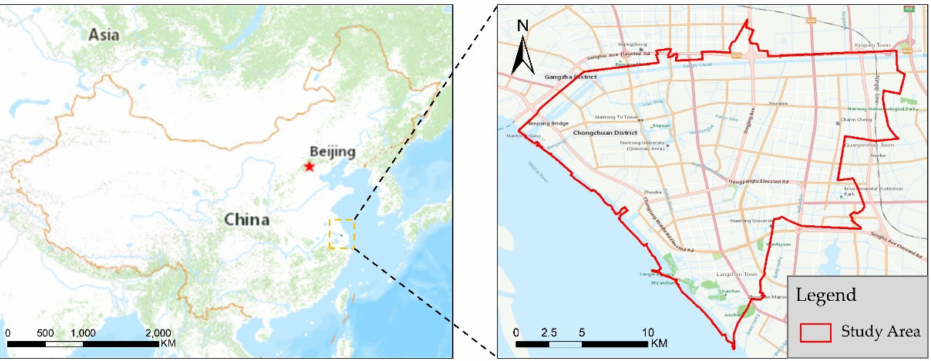
Figure 2. Study area.